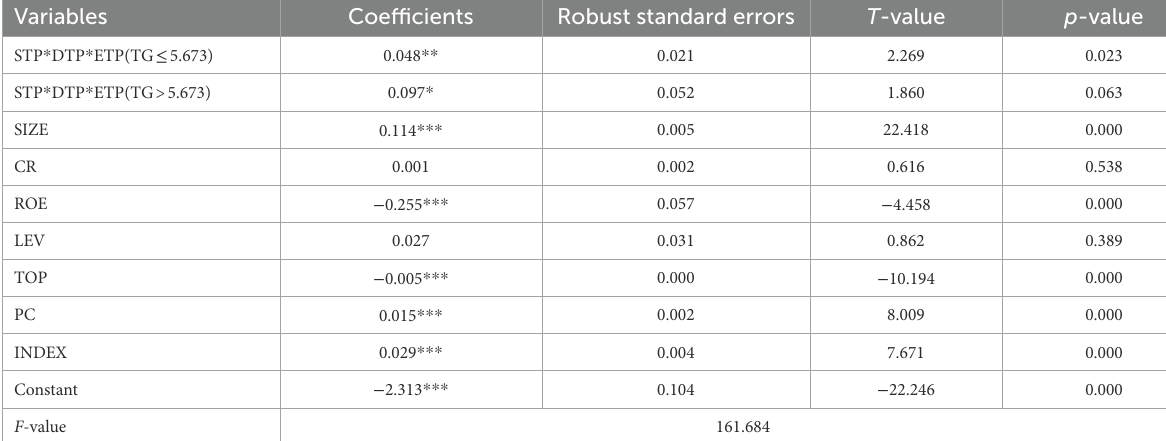
TABLE 7 Results of the threshold effect